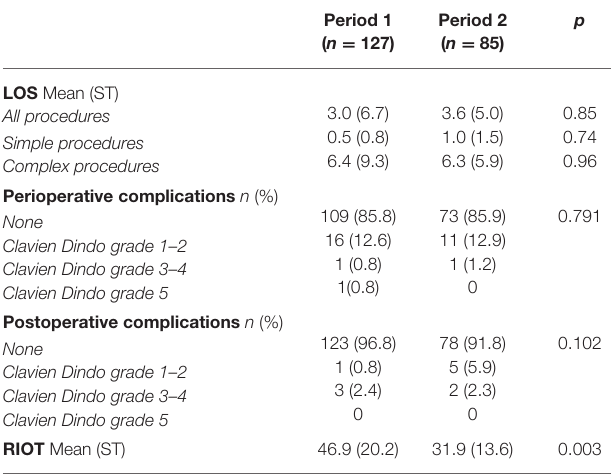
TABLE 2 | Description of surgical and oncologic outcomes between the two